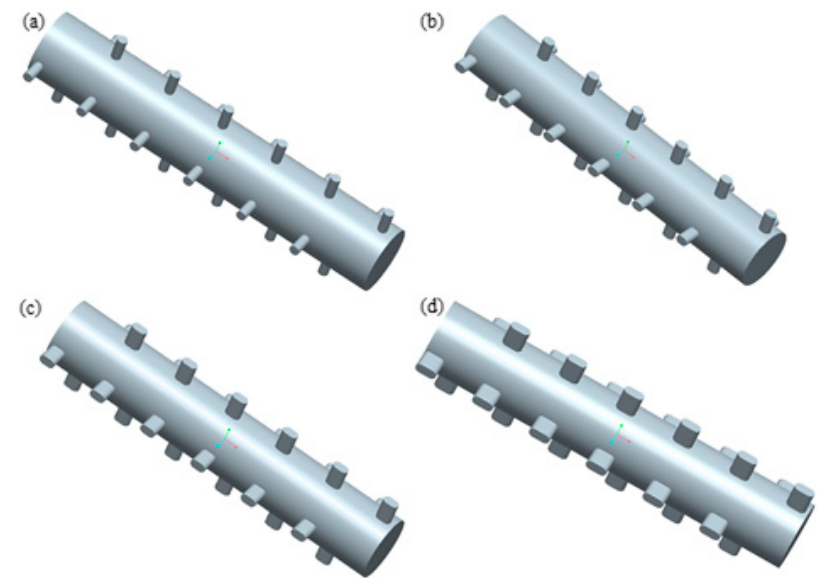
Figure 3. CAD model of different threshing rollers at the threshing component width of: ( a ) 15 mm,